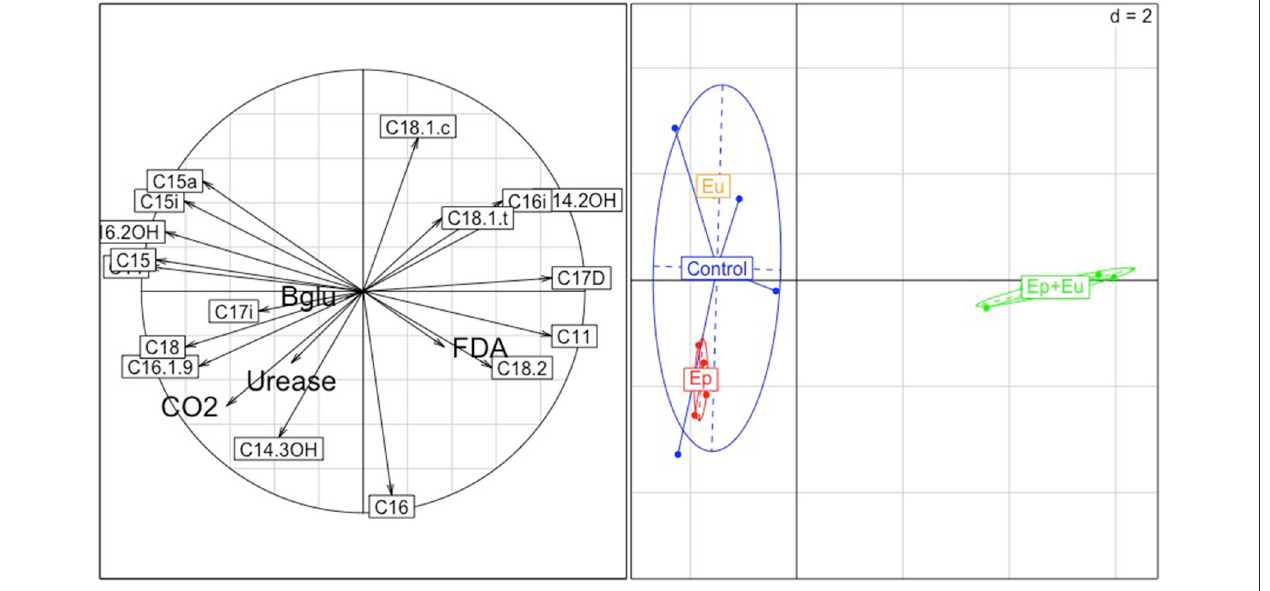
FIGURE 4 | Principal Component Analysis (PCA) of soil microbial parameters 1 month after Collembola re-inoculation. Correlation circle with the variables is on the left; and projection of the treatments on the right panel. The centroids are the barycenters of each treatment and each ellipse represents a 95% confidence interval. Control, without Collembola; Ep, Epedaphic Collembola; Eu, Euedaphic Collembola; Ep + Eu, mixed functional groups; FDA, FDA activity; Urease, Urease activity; CO2, CO 2